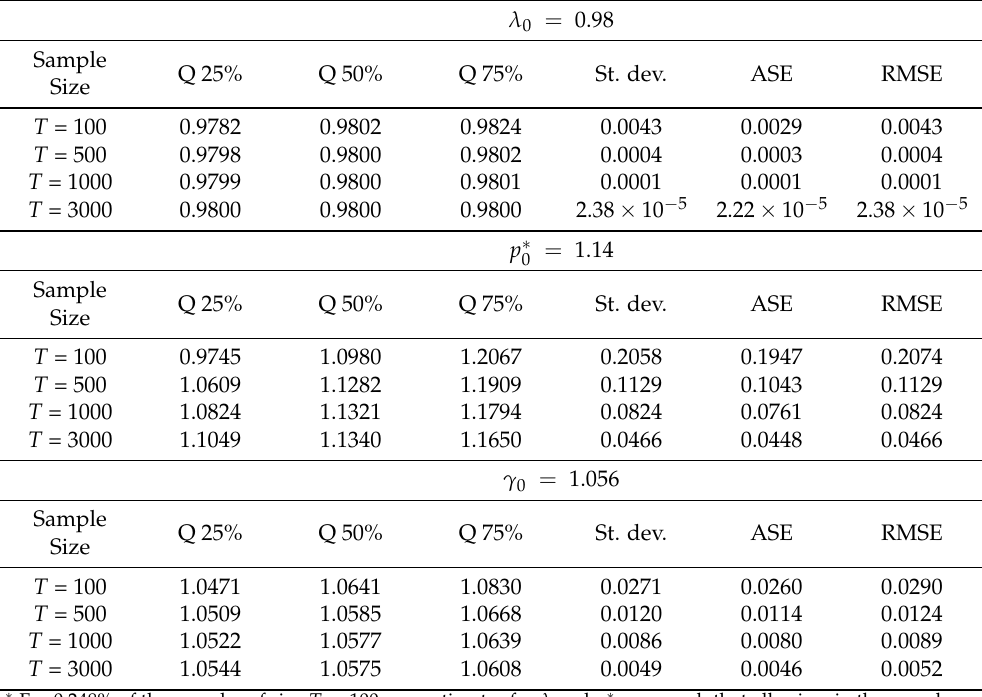
Table 3. Inverse consumption demand F(C) = C − 1 . True parameter values are λ 0 = 0.98, p ∗ γ 0 =